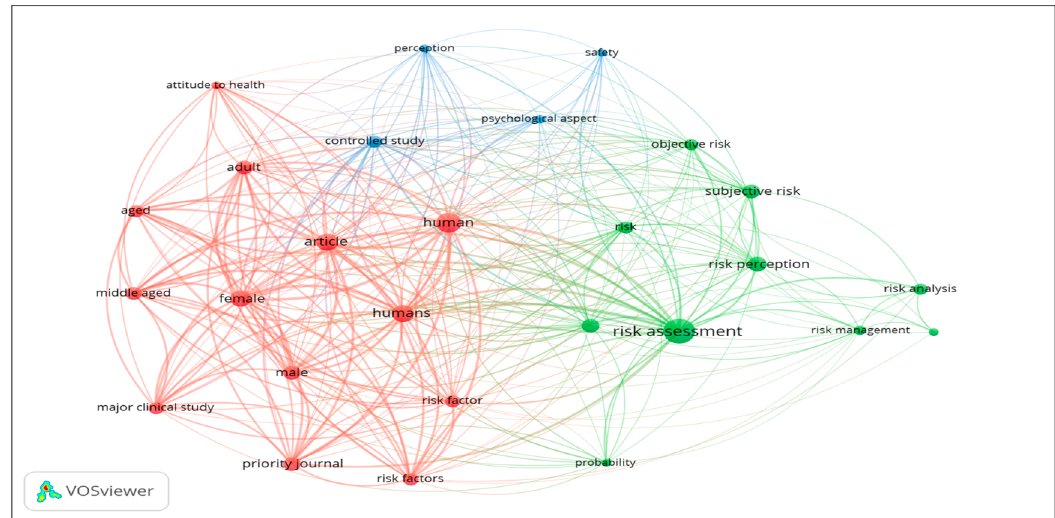
Figure 5. Visualisation map of the Clustering of Author-Supplied